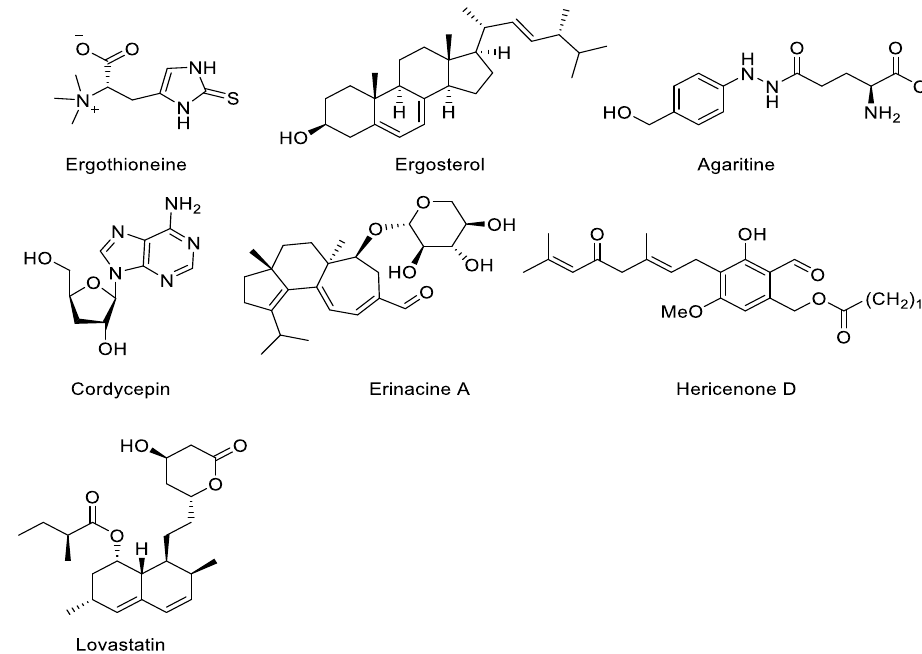
Figure 2. Chemical structures of other bioactive compounds found in